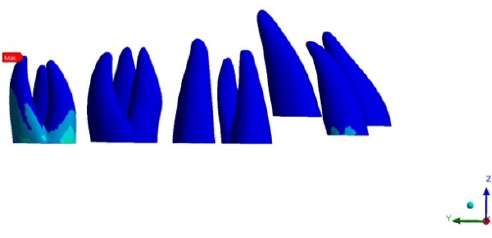
Figure 8. PDL pressure (lateral view).